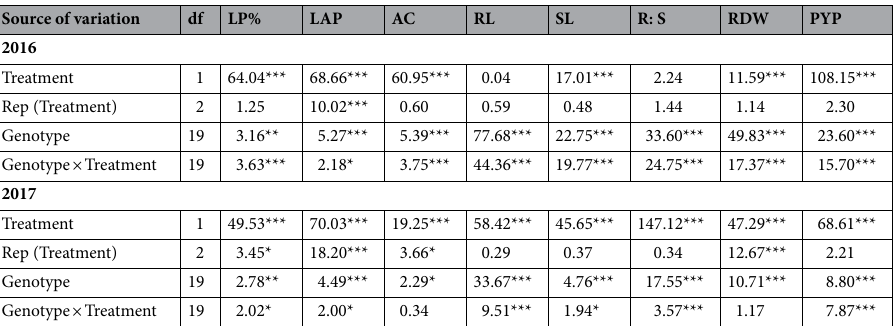
Table 1. Year-wise analysis of variance (F- value) for phosphorus use efficiency and yield related traits in groundnut. *: significant at < 0.05, **: significant at < 0.01, ***: significant at < 0.001 probability level. df— Degrees of freedom, LP% –Leaf phosphorus (%), LAP—Leaf acid phosphatase (µM/hr/gm), AC—Anthocyanin content (mg/g), RL—Root length (cm), SL –S length (cm), R: S—Root: Shoot ratio, RDW—Root dry weight (g), PYP—Pod yield per plant